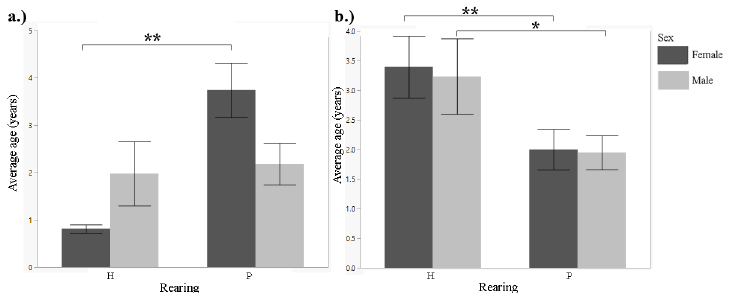
Fig 5. Mean number of years an individual lived, by rearing type (2000 – 2011). A.) Siberian tiger B.) cheetah. t-test: * p < 0.05; ** p <